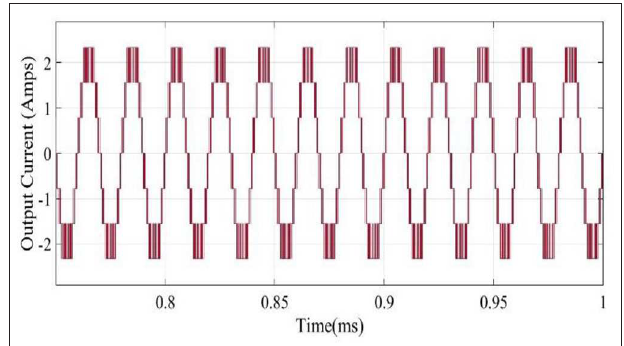
Frontiers in Energy Research |